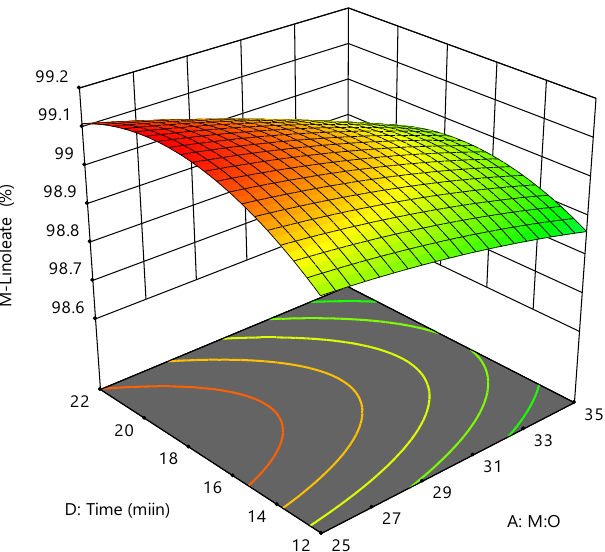
Figure A5. Response surface for the effect of M:O molar ratio and reaction time on the yield of methyl linoleate.